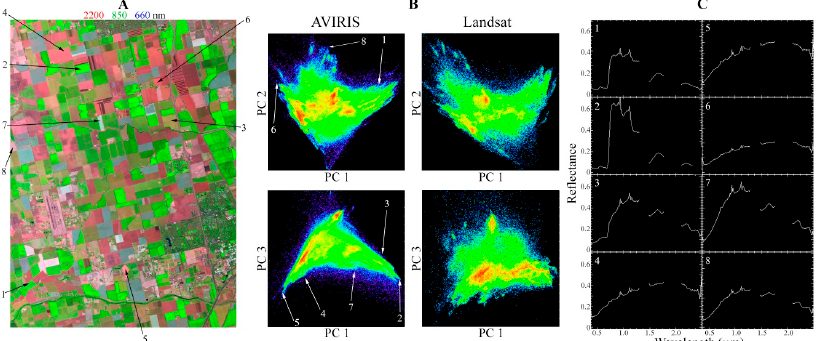
Figure 8. Spectral diversity in a 9 × 15 km region of intensive agriculture in the Great Central Valley of California. Considerably more spectral diversity is present in this hyperspectral dataset than can be adequately represented by any false color composite image Locations of spectra a-h are shown on the AVIRIS feature space and on the image. (A) . The AVIRIS feature space for this spatial subset ( B , left column ) clearly shows more prominent clustering than the Landsat feature space ( B , right column ). Green fields are characterized by a wide range of red edge and absorption properties ( C1 , C2 ). Bare or senescent fields are characterized by an even greater range of spectral shapes (C3 – C8 ). This high concentration of spectral diversity is consistent with the similarity in dimensionality and feature space topology between the limited area of this study and the much more extensive global studies of Small & Milesi (2013) and Sousa & Small